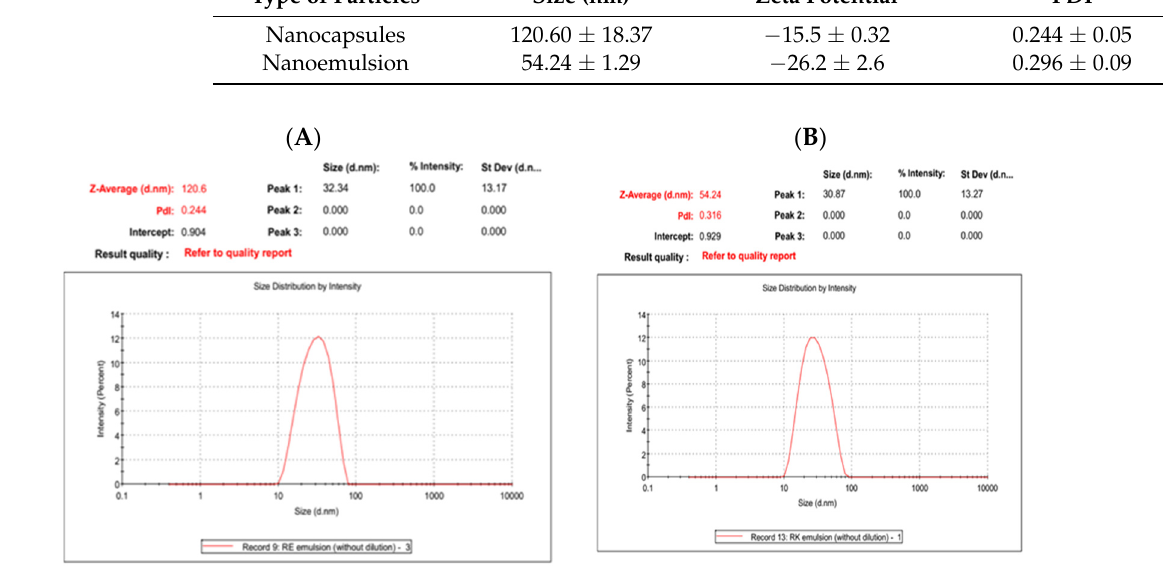
Figure 1. Particle size distribution of ( A ) O. glandulosum Desf. oil nanocapsules and ( B ) nanoemul- sion. Table 2. Average size and z-Potential of O. glandulosum Desf. oil nanoemulsion and nanoencapsu- lation.